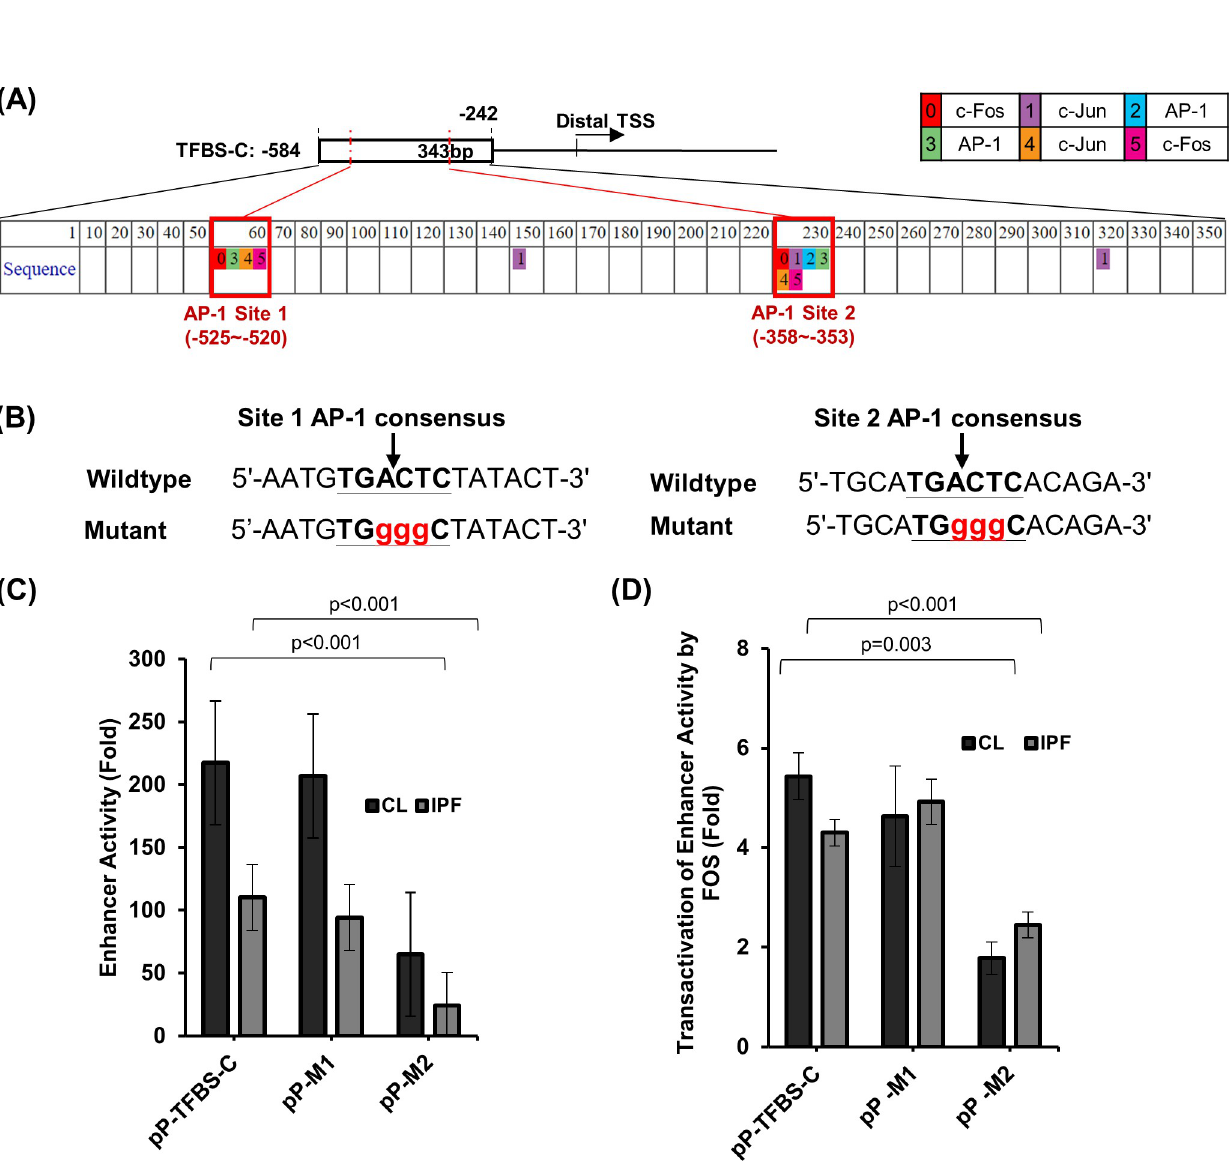
Fig 4. Functional AP-1 binding site associated with the distal enhancer. (A) Locations of AP-1 binding site clusters in the distal enhancer identified using the PROMO prediction online tool are shown. (B) Mutation of AP-1 consensus sequences for both site 1 and site 2. AP-1 sites are bolded and underlined. Mutated nucleotides are in red lower cases. (C) Enhancer activities of the pGL2promoter reporter plasmids with wildtype AP-1 or AP-1 site specific mutations in the distal RXFP1 enhancer in control (CL) and idiopathic pulmonary fibrosis (IPF) lung fibroblasts. Vector pGL2promoter (pP) was used as a control. (D) Increases of enhancer activities of the wildtype and mutant AP-1 binding site reporters by over-expressing FOS in control and IPF lung fibroblasts are shown. A FOS expression plasmid driven by CMV promoter was co-transfected into the fibroblasts with each reporter. Co-transfection with pcDNA3 was used as a control to calculate the fold increase in enhancer activity by FOS. Three control and 3 IPF independent lung fibroblast lines were analyzed in quadruplicates in each experiment. Representative results from one control and one IPF are shown as mean ± standard deviation. For (C) and (D), p-values for pairwise comparisons of luciferase activity using student’s T-test (two tailed) are shown.